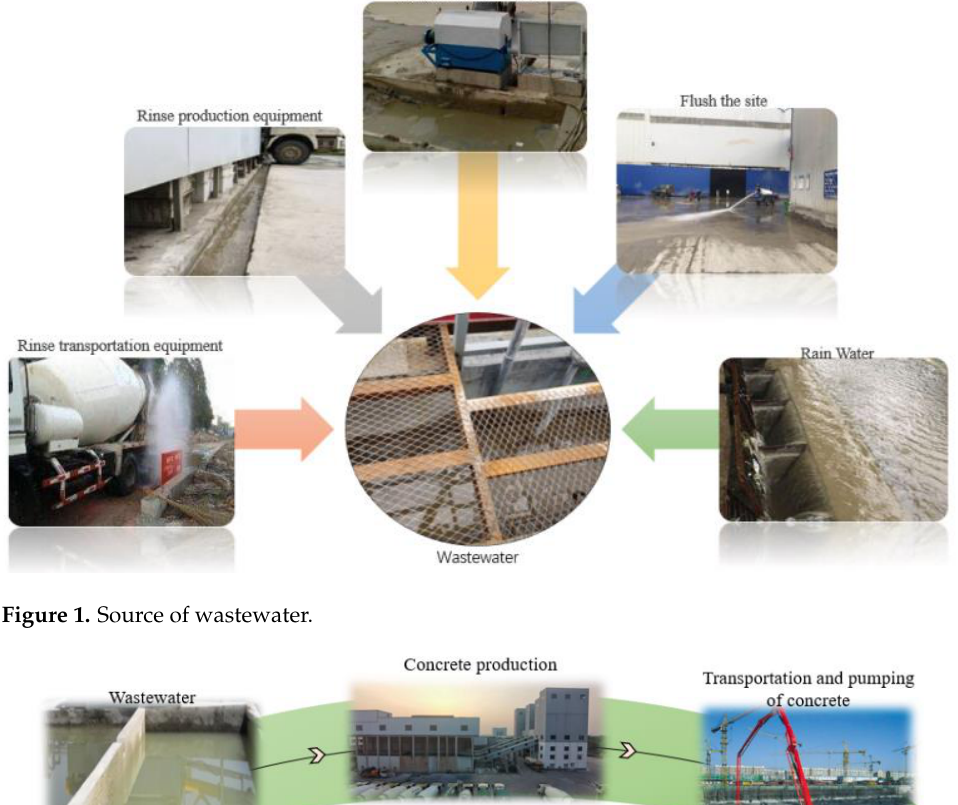
Figure 1. Source of wastewater.